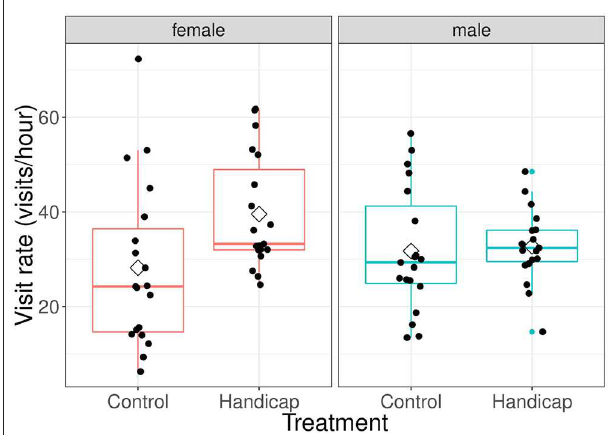
FIGURE 1 | The effect of treatment on visit rates (visits/hour) for both male and female parents when nestlings are 9 days old. Boxplot distribution with mean (diamond) and data points are represented. Sample sizes: females handicap n = 22, control n = 21; males handicap n = 22, control n = 21.